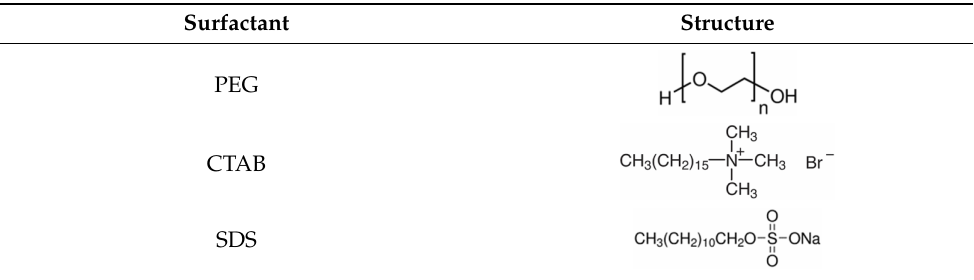
Table 1. Surfactants used for the coating of ZnO